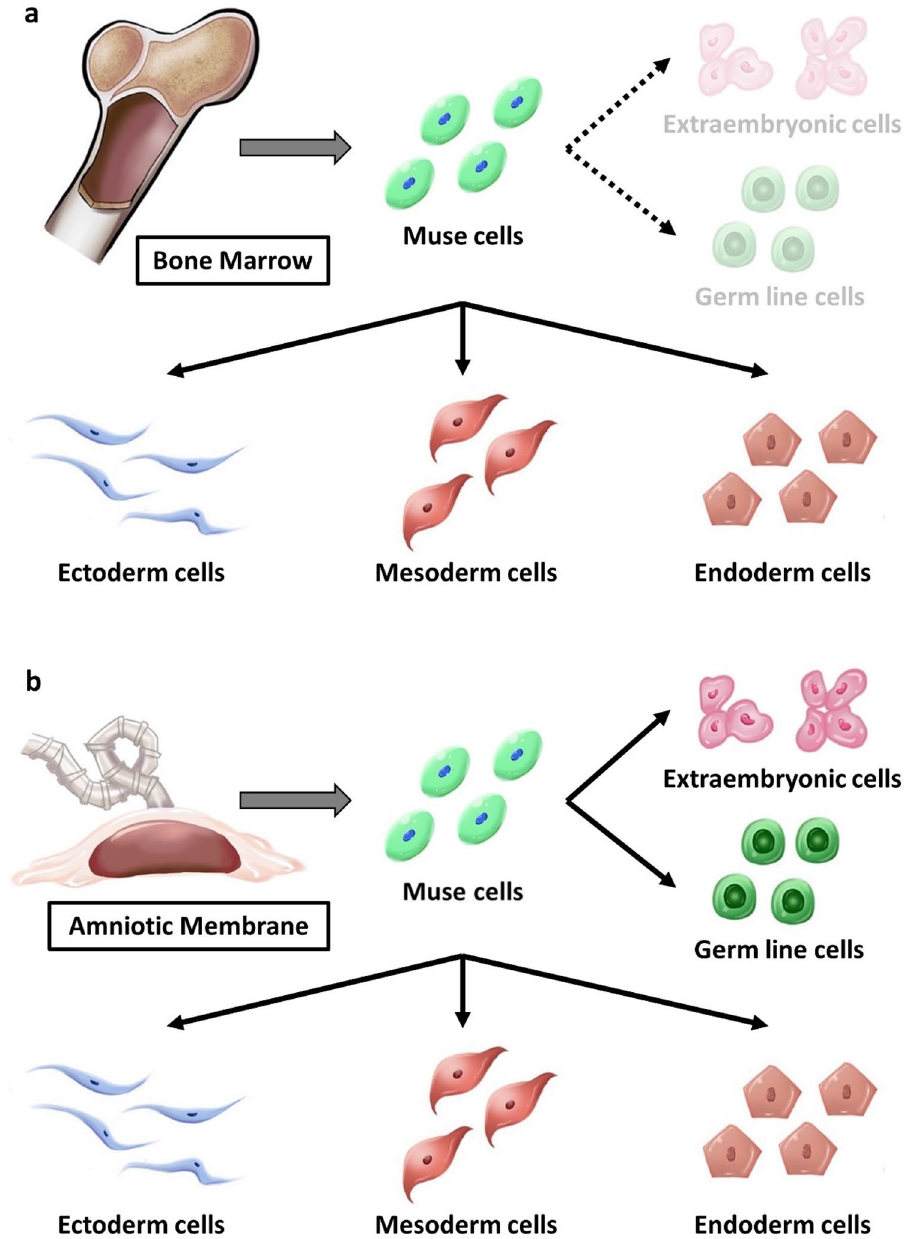
Figure 6. Differentiation potential of hBM- and hAM-Muse cells. ( a , b ) Schematic images of the differentiation range of hBM- ( a ) and hAM-Muse cells ( b ). Both hBM- and hAM-Muse cells differentiated into cells representative of all 3 germ layers, but hBM-Muse cells exhibited a partial response to germline and extraembryonic cell inductions ( a ), while hAM-Muse cells are suggested to have a broader differentiation potential into not only triploblastic-lineages, but also germline- and extraembryonic-lineages ( b